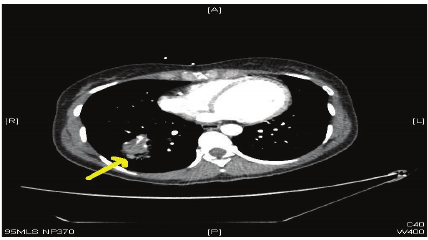
Figure 1: CT scan with contrast showing a right lung abscess, the most likely seeding source for patient 1’s invasive muscle infection.